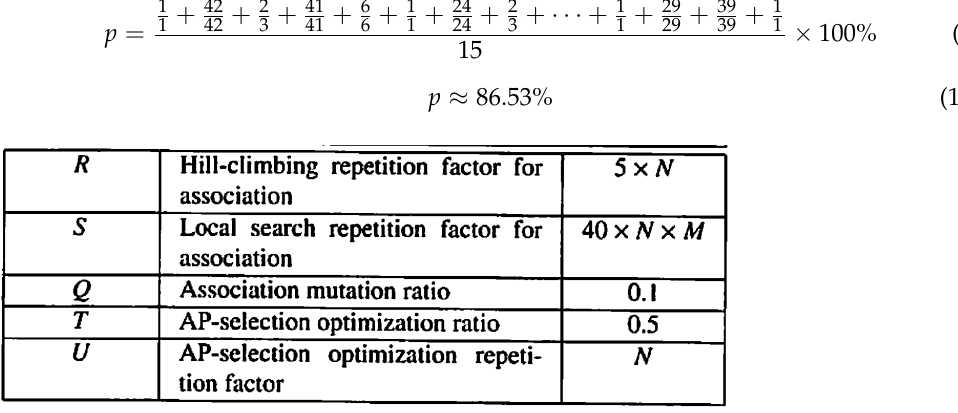
Figure 25. Printed table of scanned table image 5.